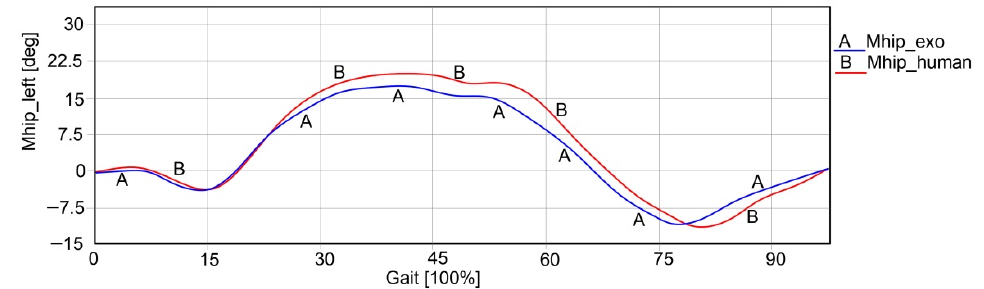
Figure 30. Left hip angular variation exoskeleton vs. human subject during a complete gait.